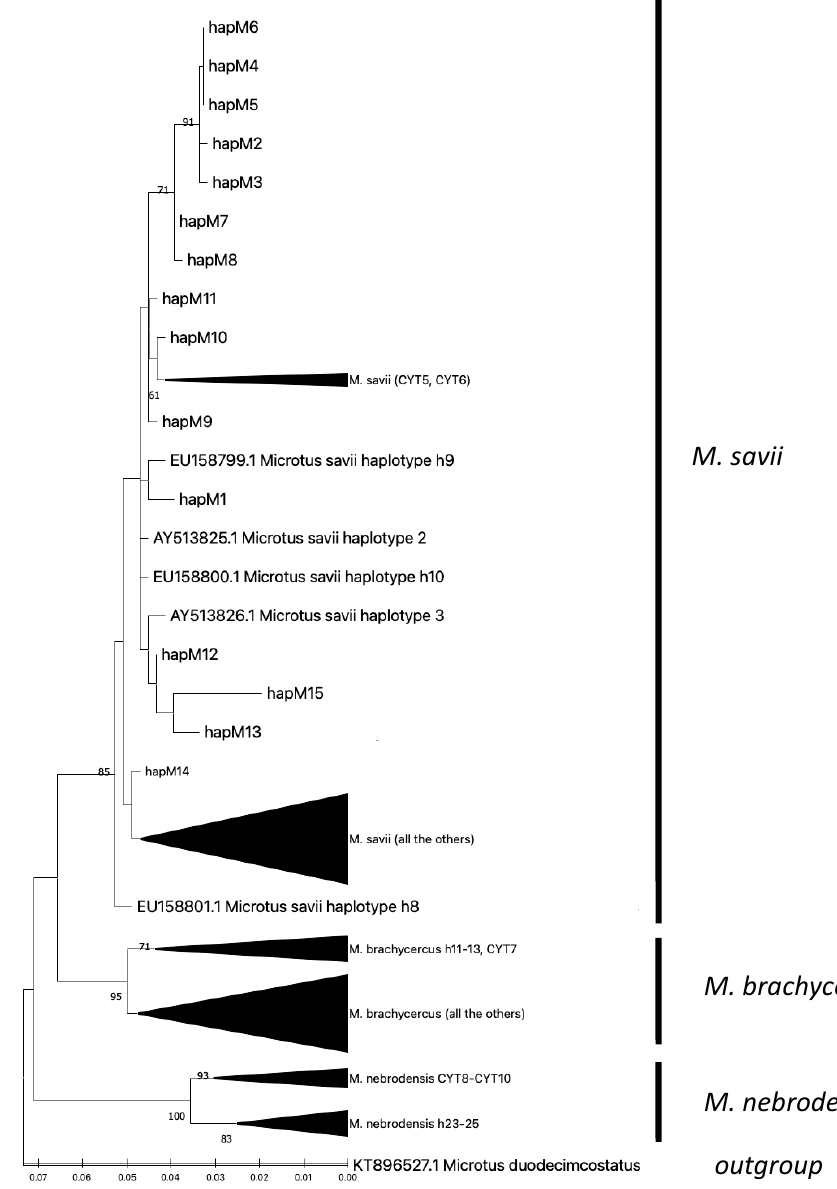
Figure 8. Maximum Likelihood performed using the Jukes–Cantor model. The percentages of replicate trees in which the associated taxa clustered together in the bootstrap test (500 replicates) are shown next to the branches [44]. The tree is drawn to scale with branch lengths in the same units as those of the evolutionary distances used to infer the phylogenetic tree. Codon positions included were 1st + 2nd + 3rd + Noncoding for 552 positions in the final dataset.